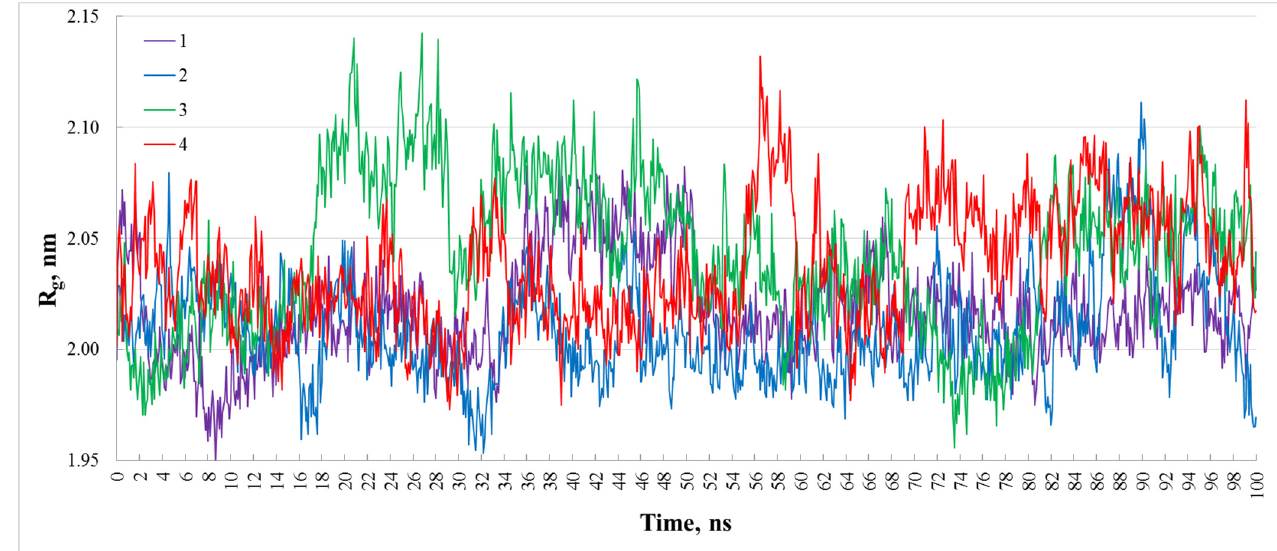
Figure 3. Graphs of the gyration radii R g of C α atoms of different models of dimers simulated in a solution with a precipitant: with Na and Cl ions bound to the protein (1), only with Na ions in the dimer structure (2) and without precipitant ions embedded in the lysozyme molecule (3), as well as without Na and Cl ions both in solution and in the protein structure (4).